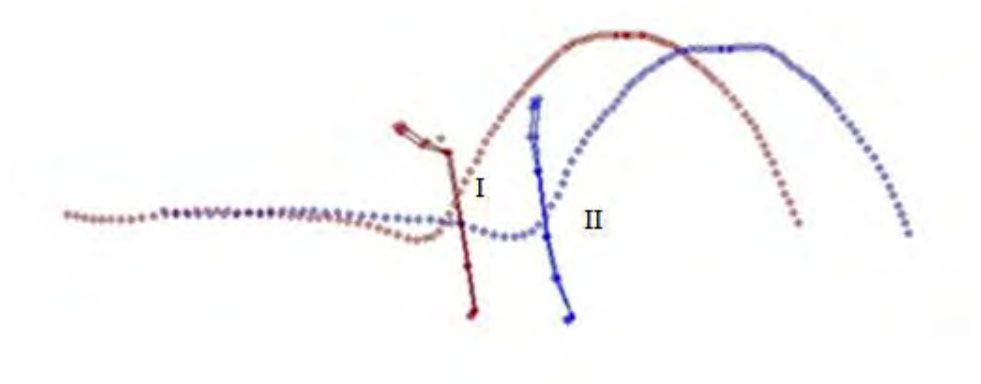
Fig.1. Phase of preparatory